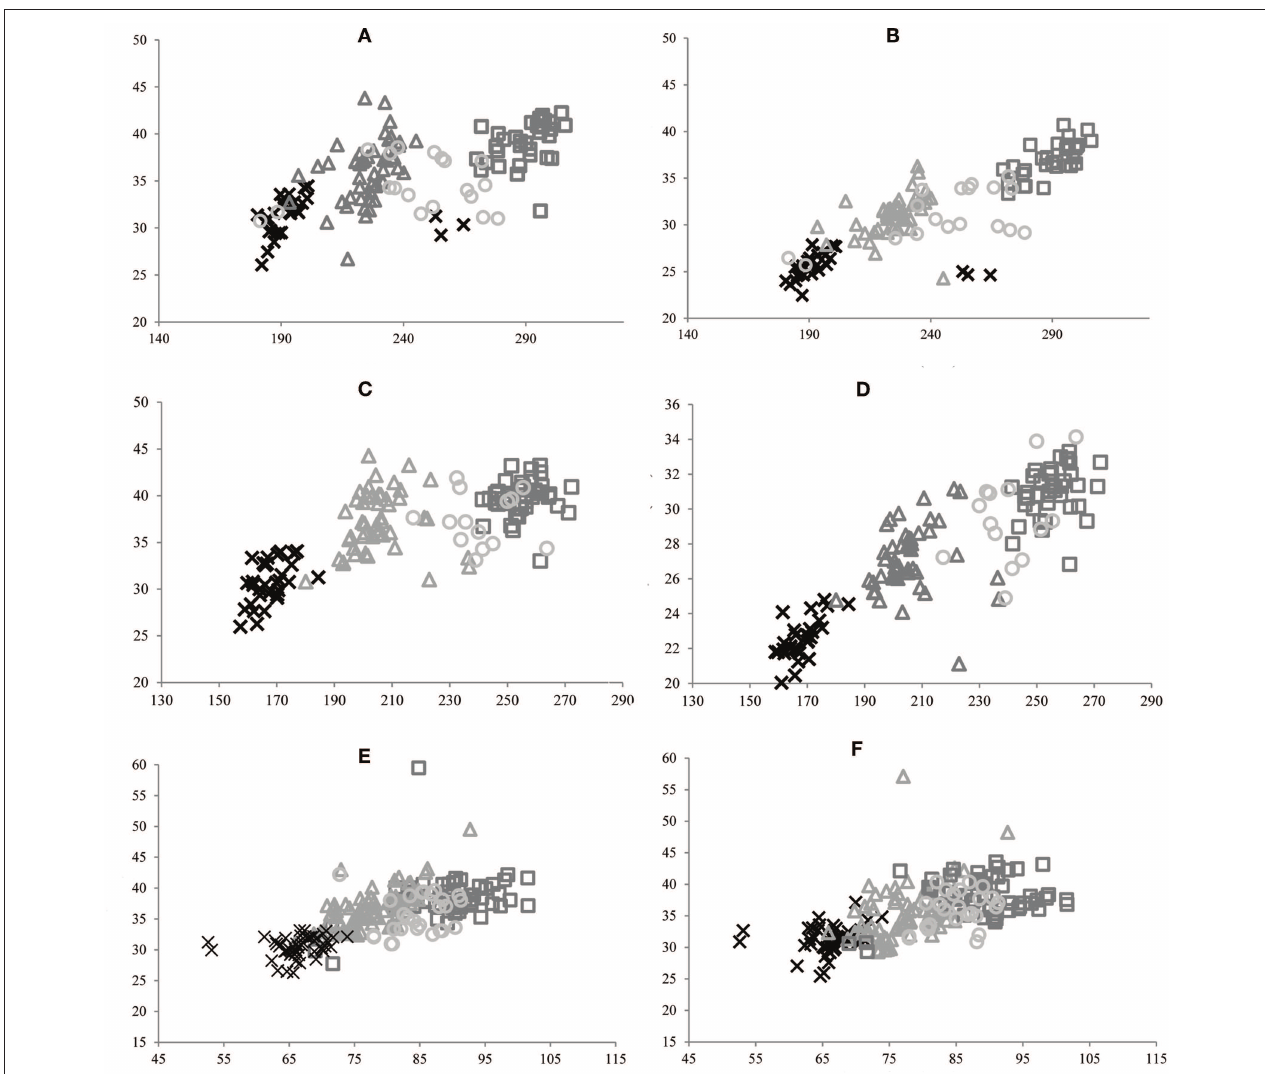
FIGURE 6 | Bivariate analysis of dimensions 1 vs. 3 (A) and 1 vs. 4 (B) of MTIII, dimensions 1 vs. 3 (C) and 1 vs. 4 (D) of MCIII, and dimensions 1 vs. 3 (E) and 1 vs. 5 (F) of IPHIII for E. andium (x), E. insulatus (triangle), E. neogeus (circle), and E. occidentalis (box).